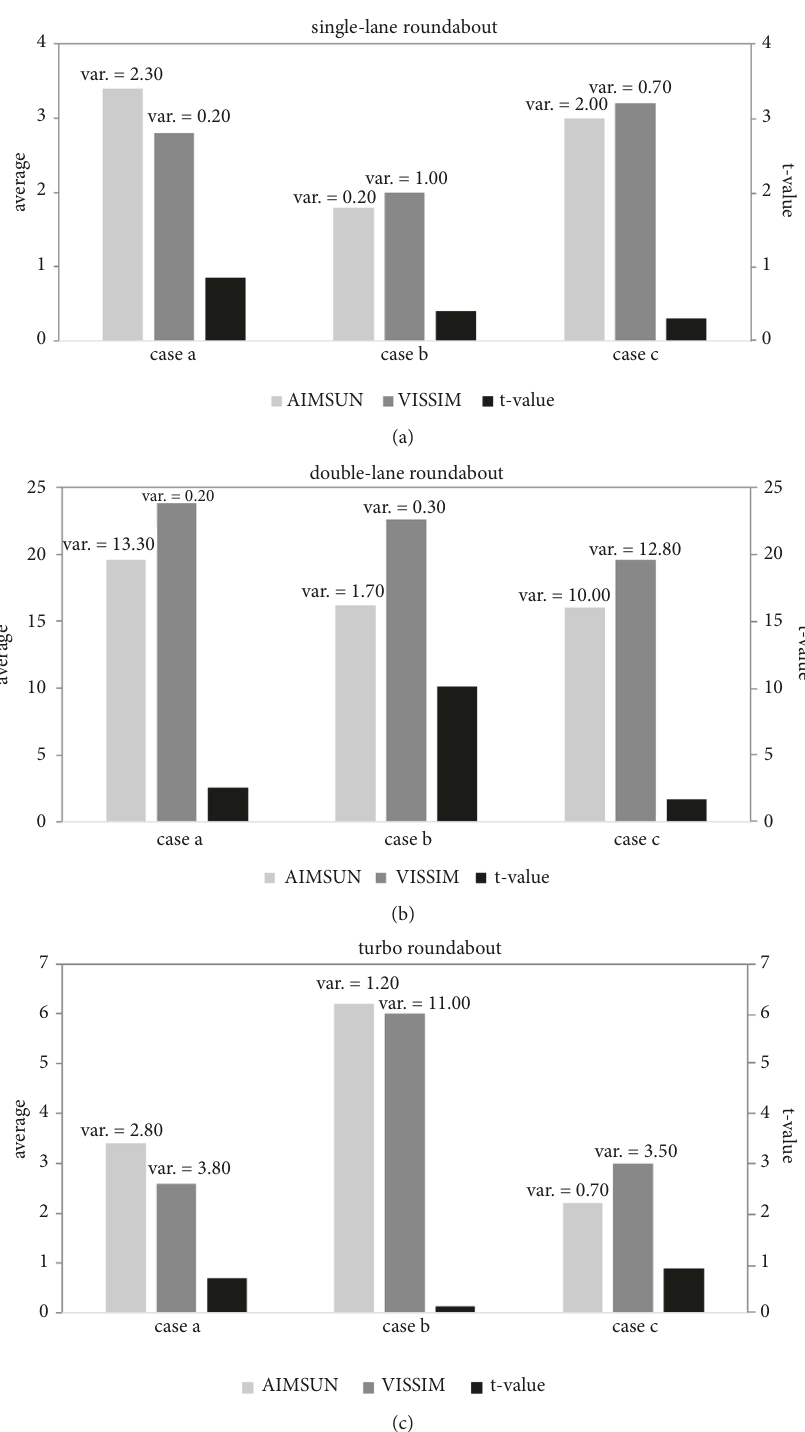
Figure 4: t-test results for VISSIM versus AIMSUN at (a) single-lane roundabouts, (b) double-lane roundabouts, and (c) turbo roundabouts. Note: T critical ( 𝛼 =0.05) = 2.31; T critical ( 𝛼 =0.01)= 3.36; average means the mean value of total conflicts in simulation replications; the t-test was not significant for single-lane and turbo roundabouts in cases a, b, and c, while t-test was significant for the double-lane roundabout in cases a and b (at the 0.05 level) and case b (at the 0.01